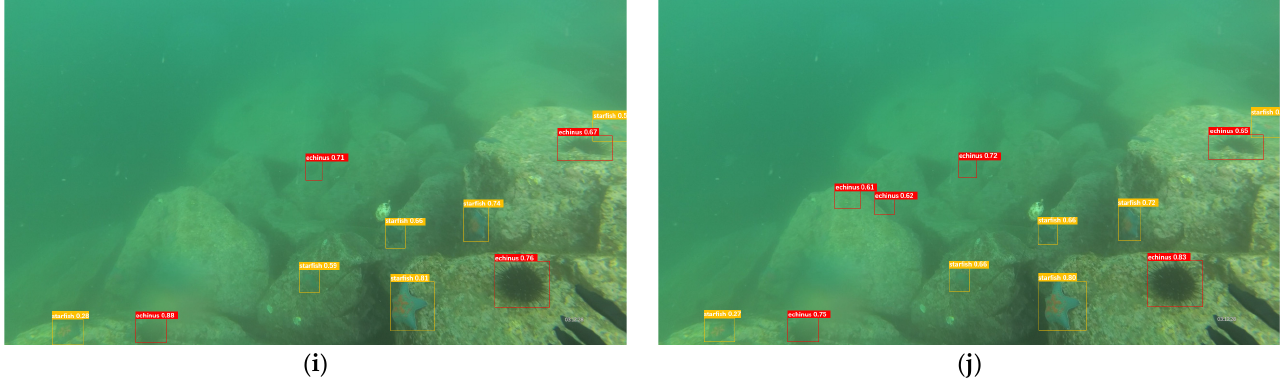
Figure 20. The typical detection results on the test set of the ablation experiment of each module: ( a ) ground truth; ( b ) detection results of the baseline YOLOv5; ( c ) detection results of the model YOLOv5 + Trident [1, 2, 3]; ( d ) detection results of the model YOLOv5 + Trident [1, 1, 1]; ( e ) detection results of the model YOLOv5 + Trident [2, 2, 2]; ( f ) detection results of the model YOLOv5 + Trident [3, 3, 3]; ( g ) detection results of the model YOLOv5 + ViT; ( h ) detection results of the model YOLOv5 + ViT + Trident [1, 2, 3]; ( i ) detection results of the model YOLOv5+ViT+DfConv; and ( j ) detection results of the proposed model. In ( b – j ), the red, blue and orange boxes represent the echinus, scallop, and starfish, respectively.